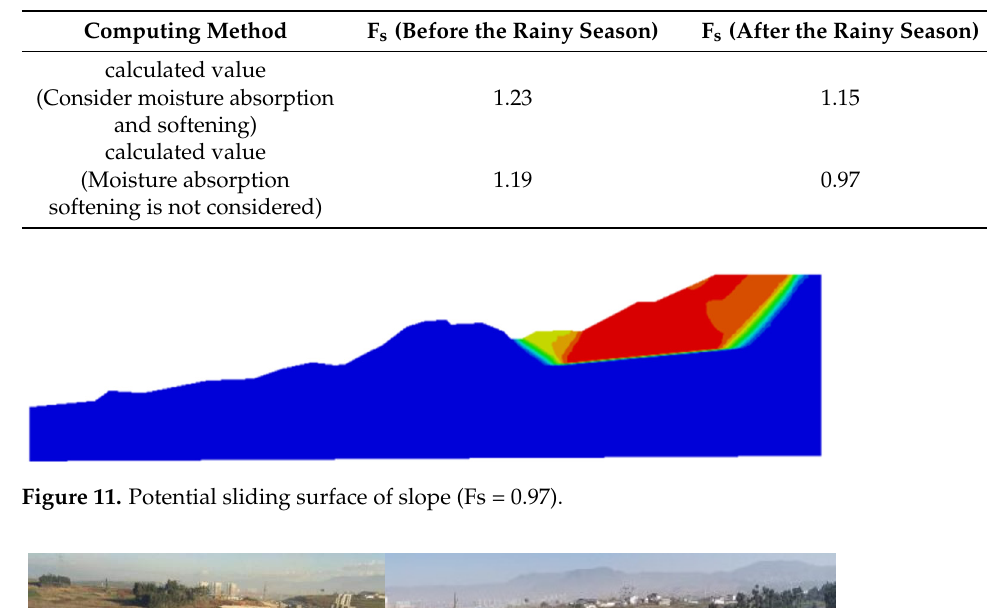
Table 5. Influence of the calculation method on the stability coefficient.